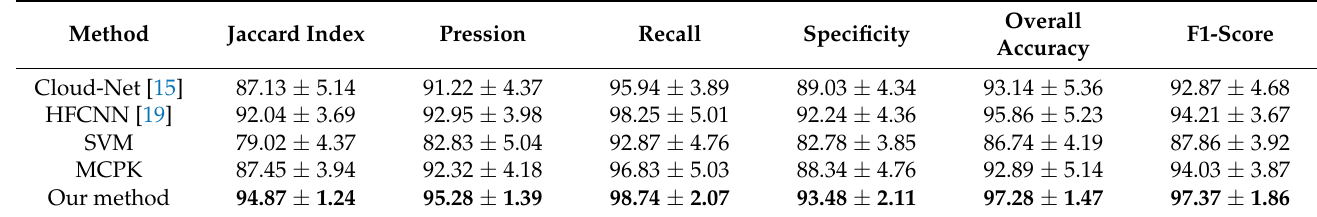
Table 3. Performance on Cloud-38 test dataset (mean ± variance